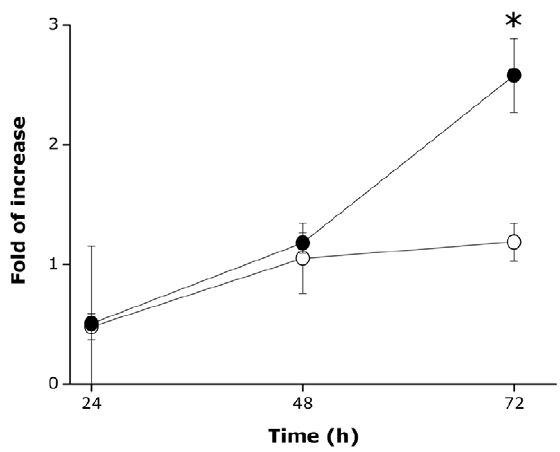
Figure 6. Recombinant expression of Myt Cc-GFP in mussels. Expression of Myt C following injection in adductor muscle of 2.5 m g of pMCV1.4 empty plasmid or pMCV1.4-Myt Ccon-eGFP. Control mussels were injected with an equal volume of PBS. The results are represented as mean 6 SD of three different biological replicates in a representative experiment. Asterisks indicate significant differences (p , 0.05) in Myt C expression in mussels injected with pMCV1.4 empty plasmid (white circles) or pMCV1.4-Myt Ccon-eGFP (black circles) relative to the expression of PBS injected mussels, previously normalized to 18S transcript levels.